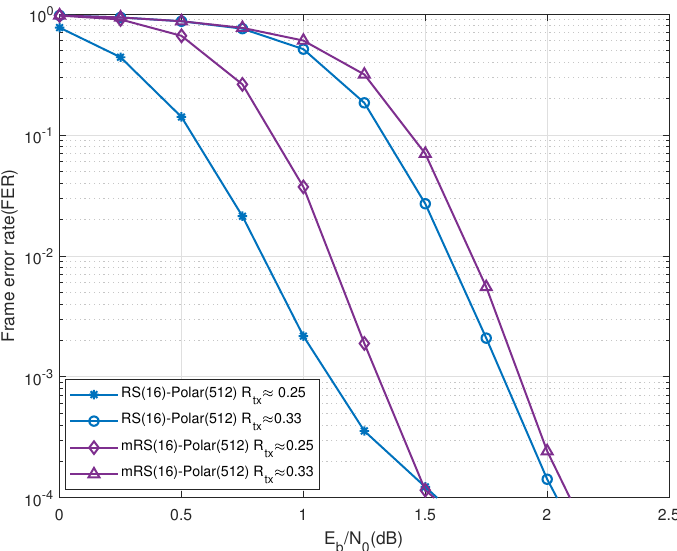
Figure 8. Performance comparison between the proposed UEP-RS-polar product scheme and the UEP-RS-polar product scheme of [8], (referred to as “mRS-polar” in the figure), for R tx ≈ 1/4,1/3 and R polar = 0.5 over AWGN channels.